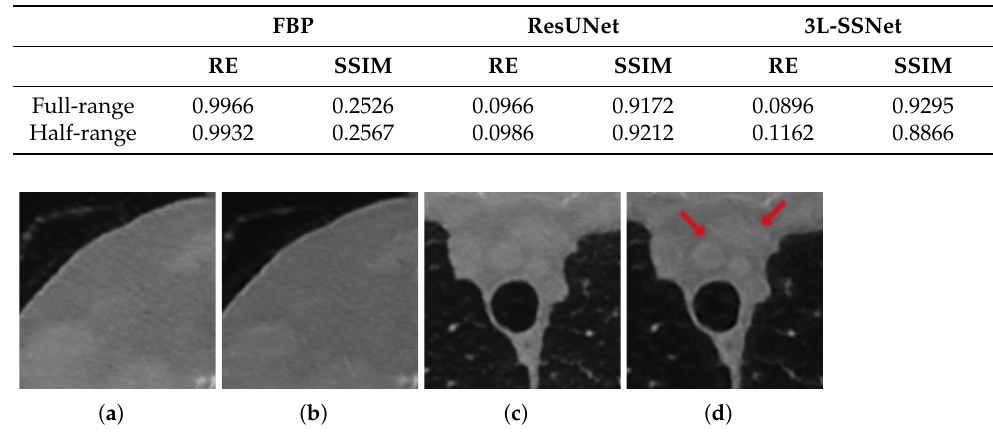
Figure 8. Crops of the reconstructions of the test patient with unseen noise and half-range geometry. ResUNet in ( a , c ), 3L-SSNet in ( b , d